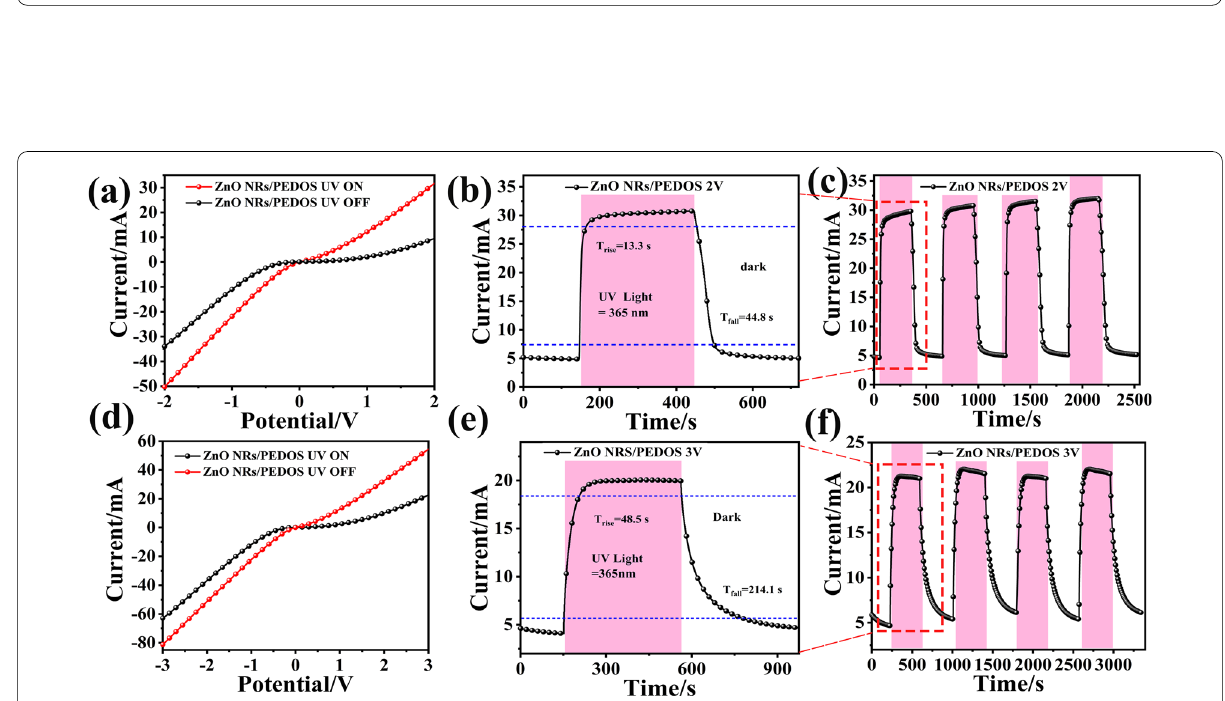
Fig. 5 a , b single-cycle I–T curve and multicycle I–T curve of ZnO NRs UV PD. c , d single-cycle I–T curve and multicycle I–T curve of ZnO NRs/PEDOS UV PD